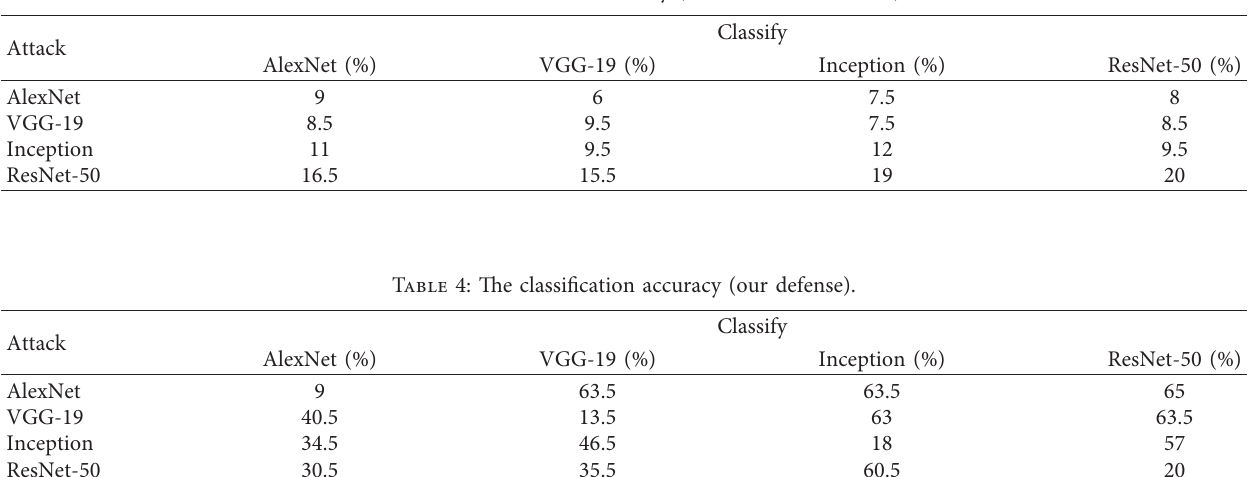
Figure 8: Transferability test (blue: our defense method and orange: randomization defense). The AlexNet model was attacked with EOT- PGD under different defenses to generate an adversarial example. Then, the adversarial examples were classified by using the AlexNet and ResNet-101 (solid and dashed lines represent the AlexNet and the ResNet-101, respectively). Table 3: The classification accuracy (randomization defense).